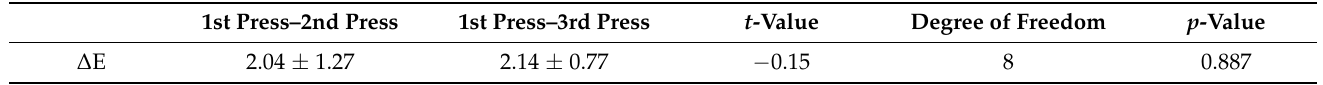
Table 4. Color change after second press (P1–P2) and third press (P2–P3)